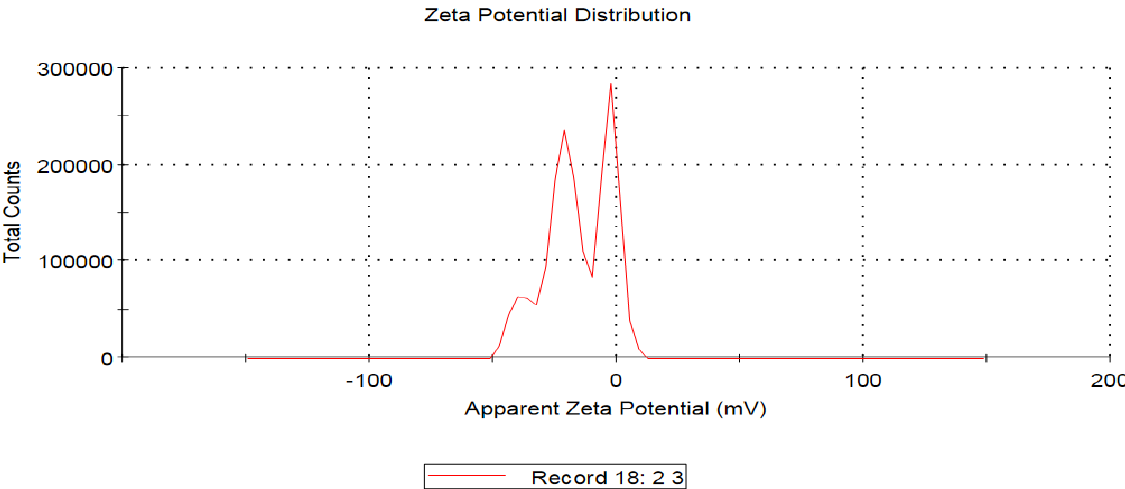
Figure 9. Zeta potential analysis of the biosynthesized AgNPs formulated using pomegranate peel extract.